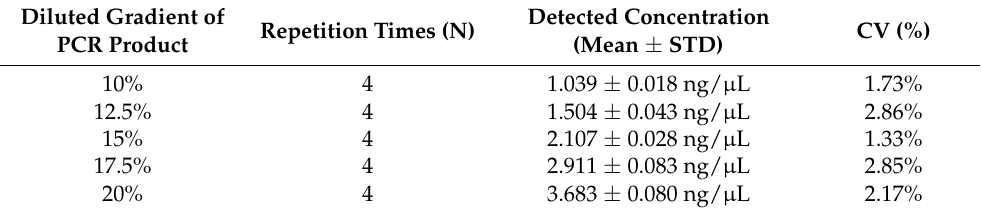
Table 1. Detected concentrations of gradient PCR products of the nuc